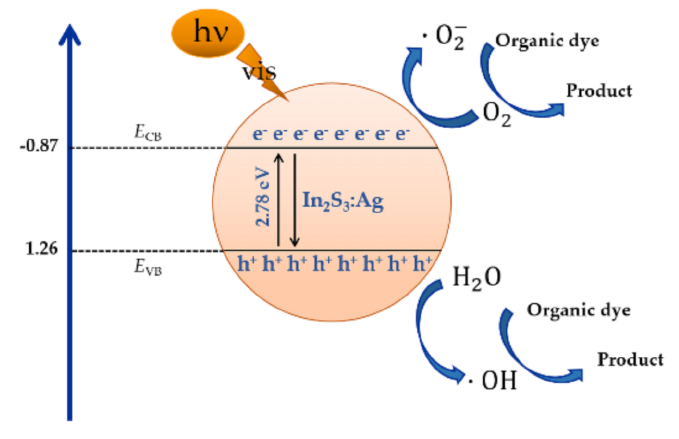
Figure 8. Photocatalytic mechanism of In 2 S 3